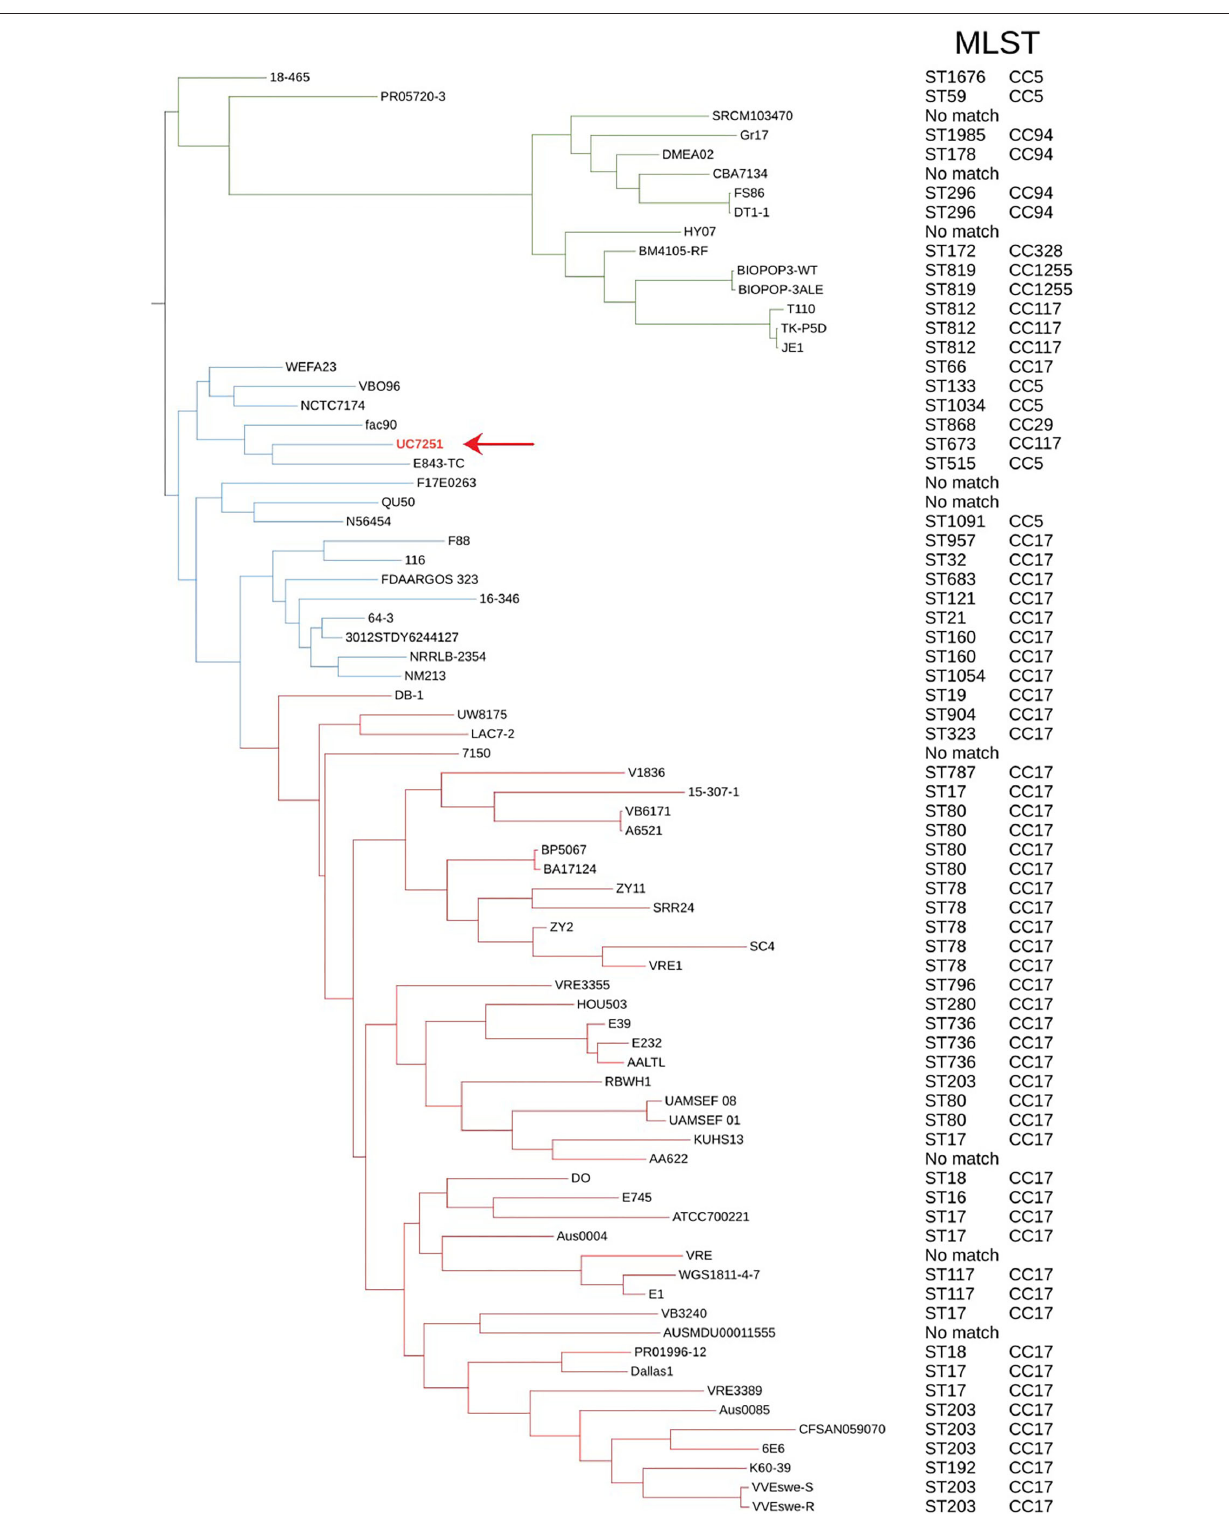
Frontiers in Microbiology |